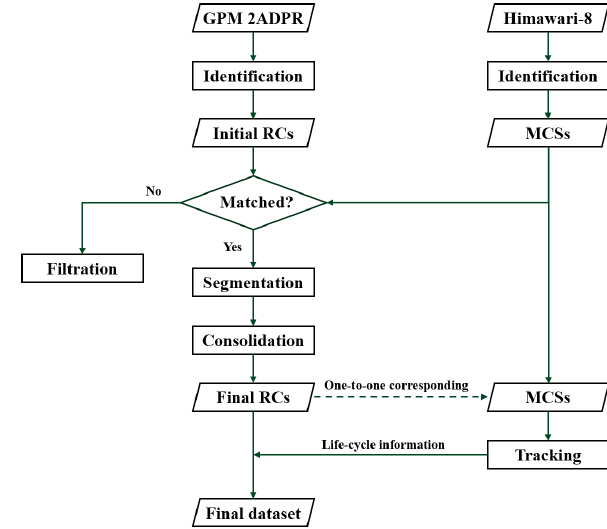
Figure 2. Processing flowchart for our